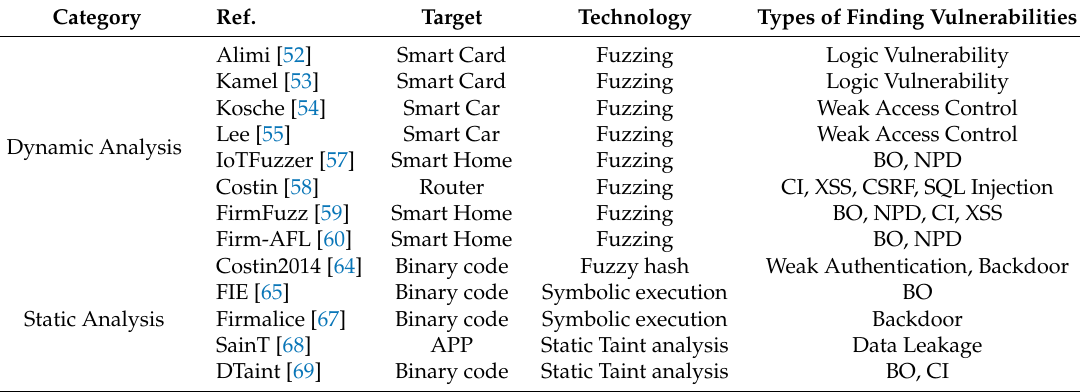
Table 2. This table is a summary of IoT device vulnerability discovery technology. BO = Buffer